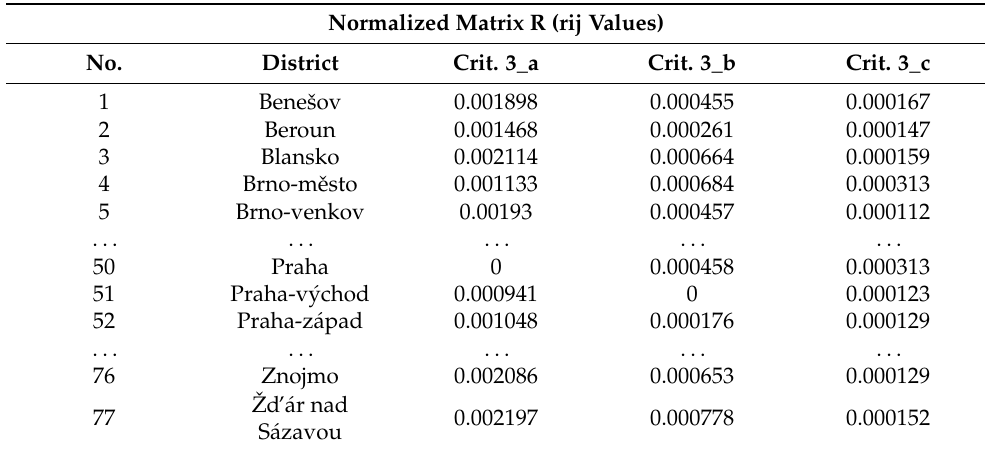
Table A6. Normalized matrix for 3rd area for TOPSIS—selected districts. Normalized Matrix R (rij